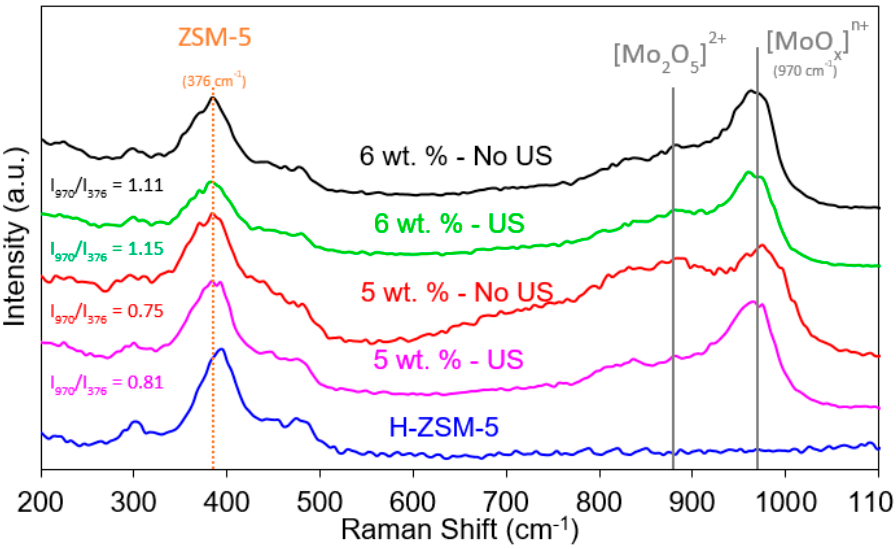
Figure 2. Raman spectra of H-ZSM-5 and Mo/ZSM-5 catalysts prepared by ion-exchange with ultrasound (US) and without ultrasound (No US).